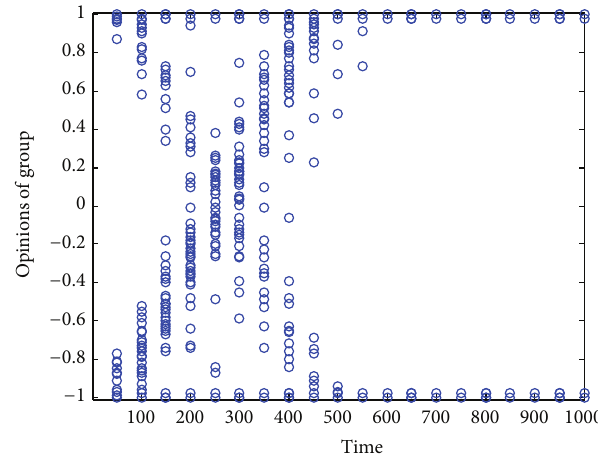
Figure 6: Group opinions change with time. 𝑎 = 1 , 𝑏 = 𝑐 = 0 , and 𝑥 ∈ [−1,1] (continuous opinions).